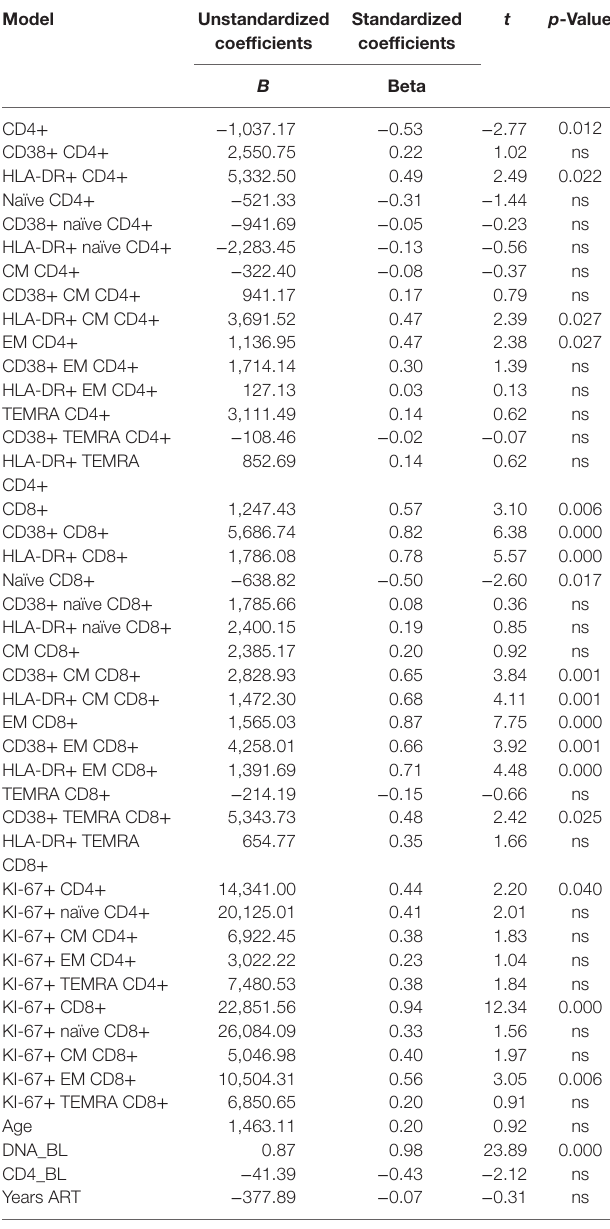
TaBle 2 | Univariate linear regression analysis between changes in HIV-1 DNA copies [baseline minus 1 month from vaccination (dependent variable)] and immunological and clinical parameters (independent